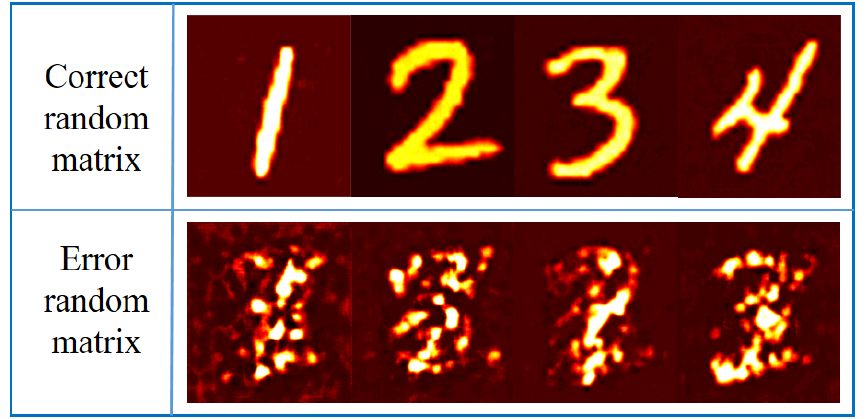
Figure 10. Decryption results under different random matrices.